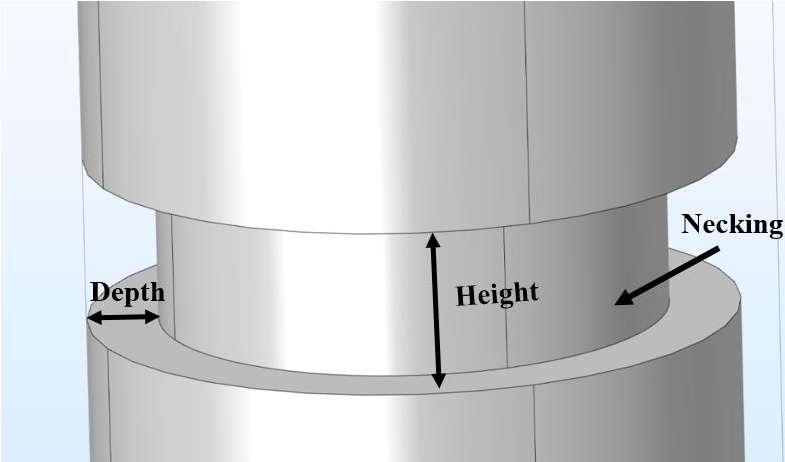
Figure 4. Sketch of necking defect for forward and inverse modeling. Only one local minimum on the plot can be seen in Figure 5, which means that there is only a necking defect in the shaft. To separate necking from the void defect, one can calculate the length of the optical fiber that passes a single temperature drop in the plot. If the length is larger than one or two perimeters of the reinforcement cage with only one temperature drop, the defect can be interpreted as necking. If several temperature drops are presented continuously on the plot, one can interpret it as a void